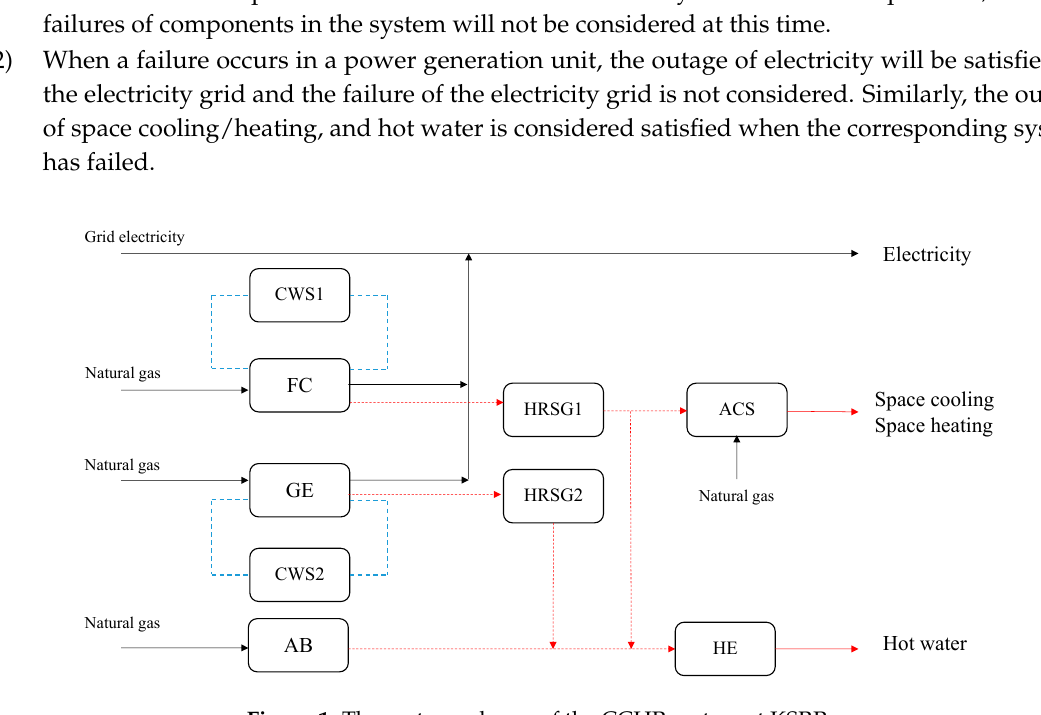
Figure 1. The system scheme of the CCHP system at KSRP. Table 2. The details of the power generation units of the CCHP system at KSRP.